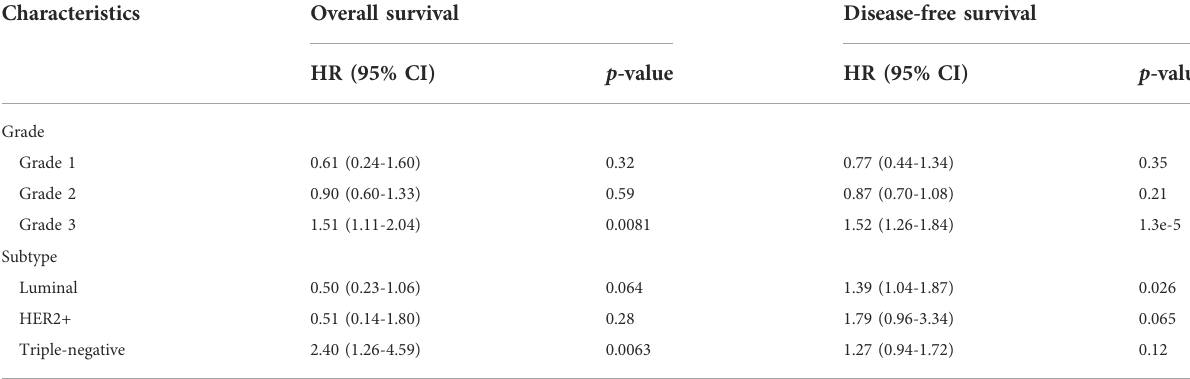
TABLE 2 The prognostic effect of FN1 expression in breast cancer patients with restricted clinicopathological characteristics.